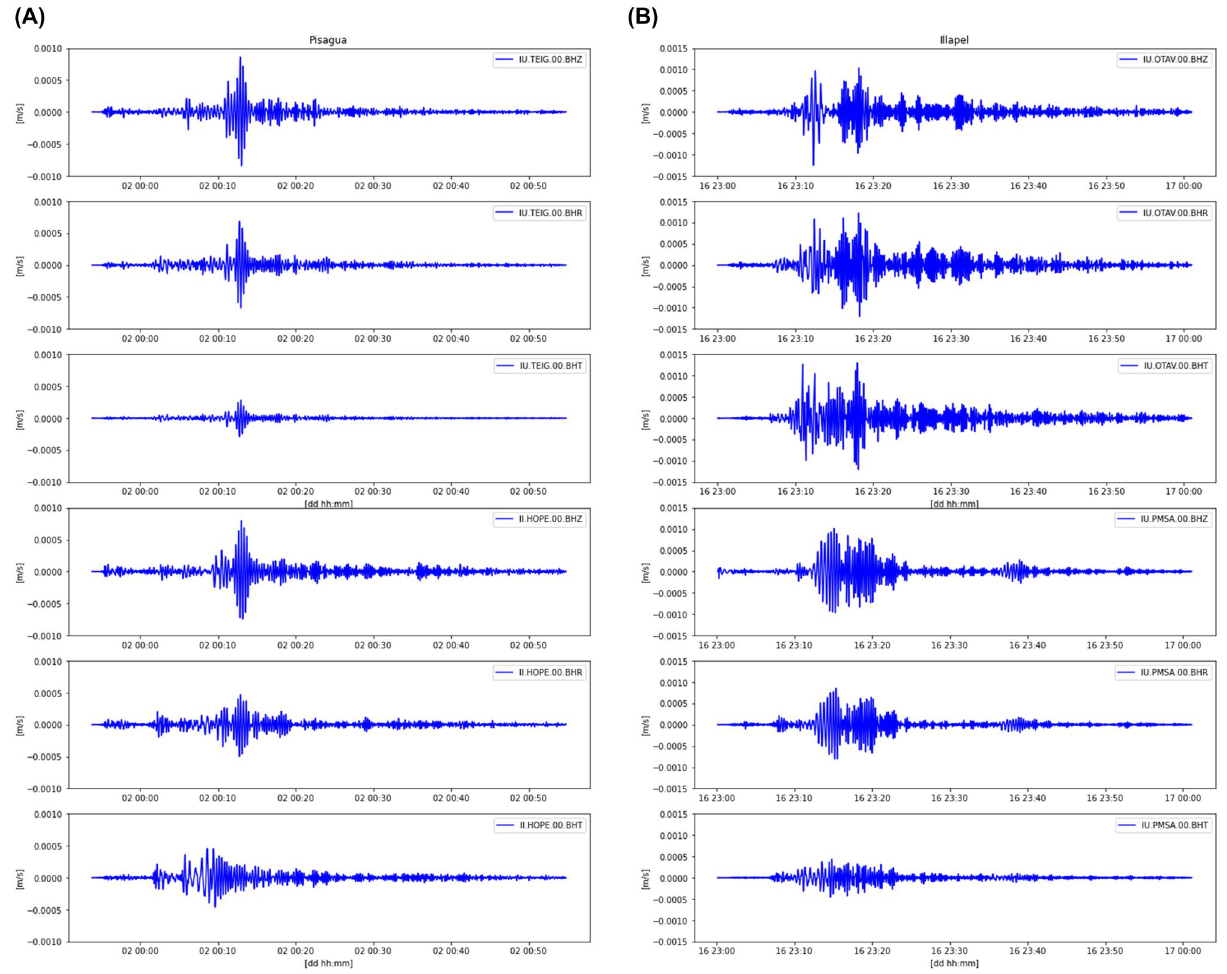
Figure 6. (A) Propagation of Raleigh wave at seismic sites TEIG (to the north) and HOPE (to the south) of the epicenter. These seismic sites are situated approximately 43° away from the Pisagua earthquake epicenter. (B) Propagation of Raleigh wave at seismic sites OTAV (to the north) and PMSA (to the south) of the epicenter. These seismic sites are located approximately 33° away from the Illapel earthquake